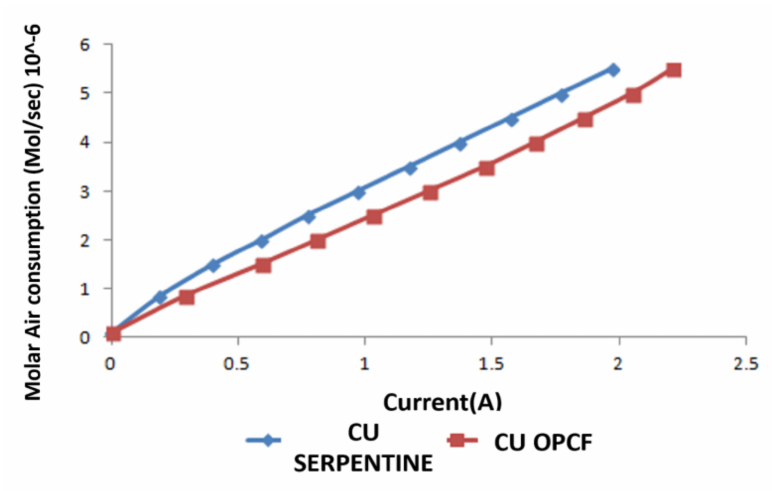
Figure 12. Air consumption (Cu bipolar plate material).